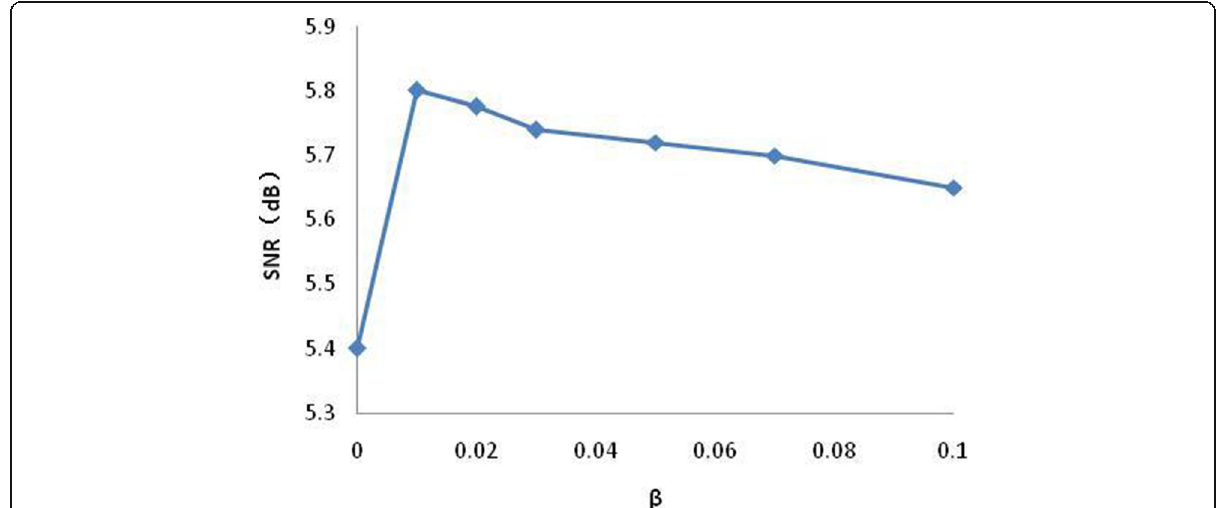
Fig. 6 Influence of balance factor β on performance